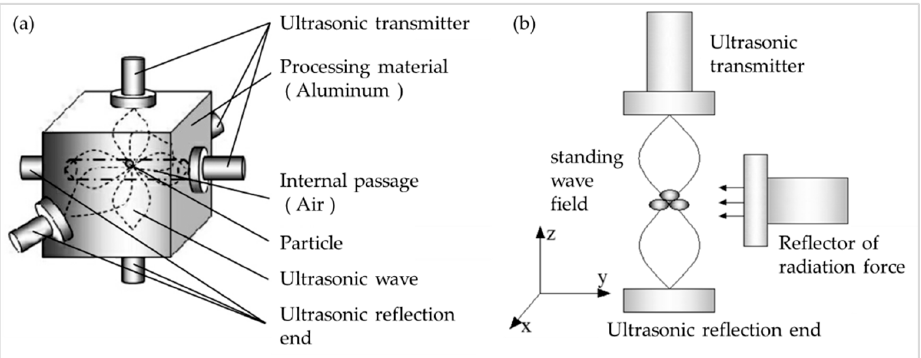
Figure 4. ( a ) Diagram of the solid medium triaxle acoustic levitation device; ( b ) Diagram of the schematic design of the acoustic levitation control system.